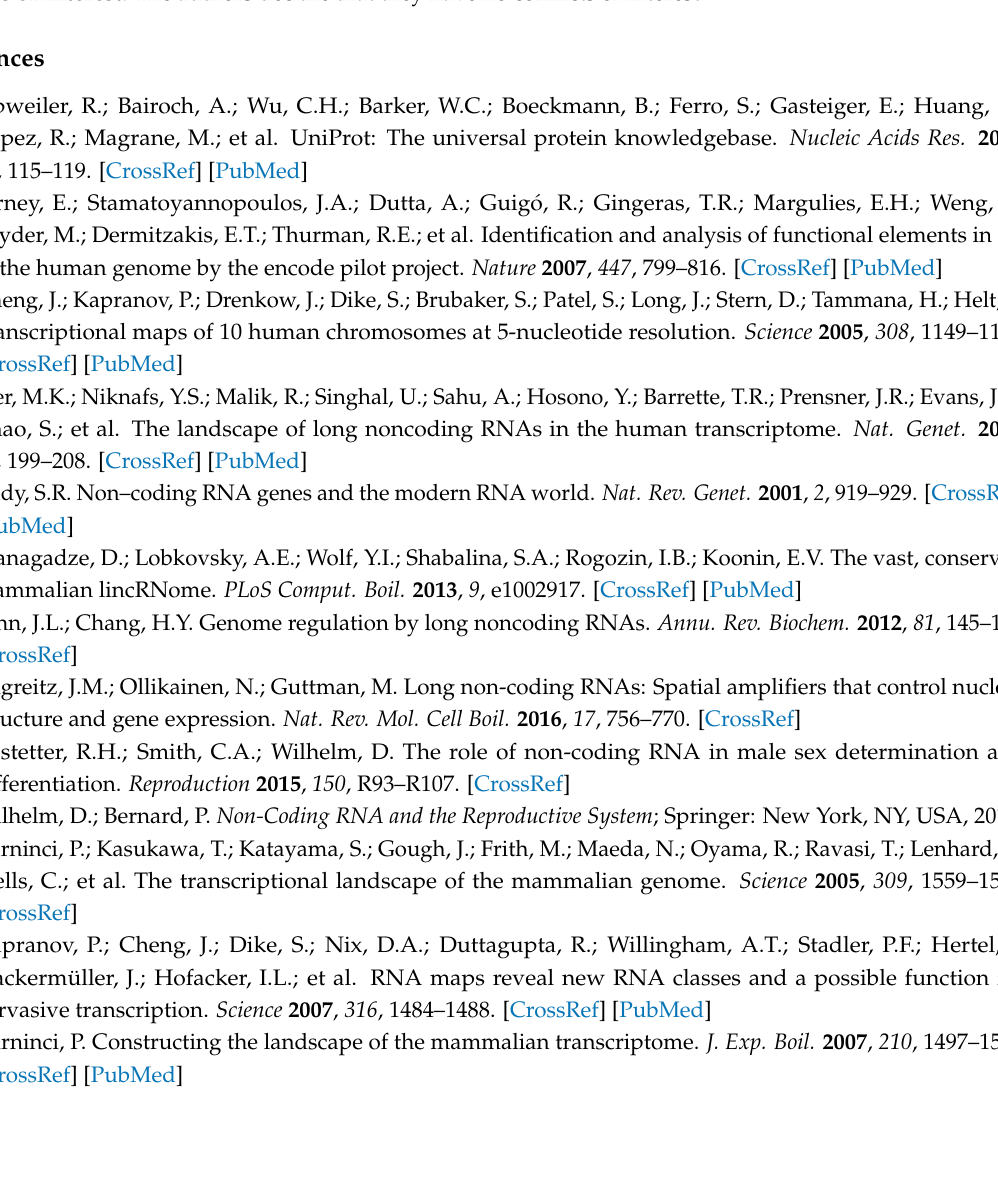
s1/. Figure S1: Genomic location of lnc-BMP5, lnc-ZBTB16 and lnc-RSPO4 in the tammar wallaby. Figure S2. Differentially expressed lncRNAs co-expression network (R ≥ 0.7). Figure S3. Negative control of lnc-BMP5 in Table S2: List of primers used for